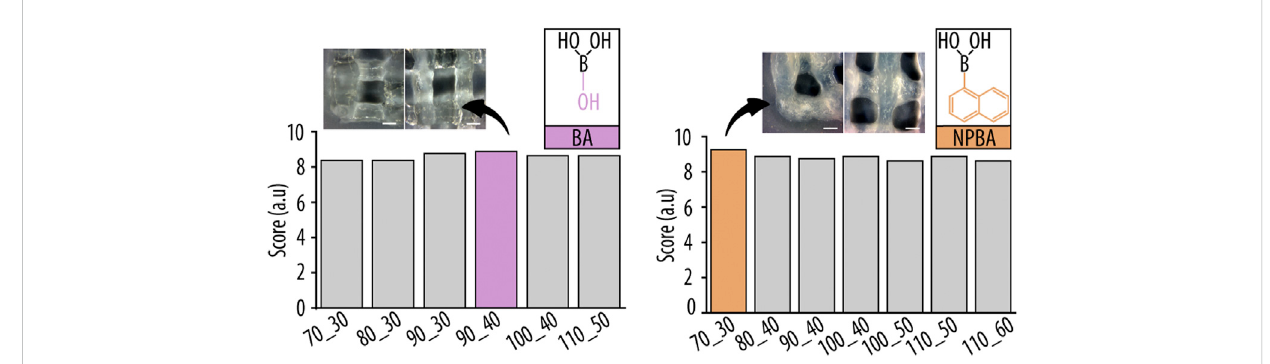
FIGURE 5 Summed and normalized printability scores of the individual hydrogel formulations obtained from fi lament fusion and collapse test. Inserts show representative images of the three dimensional (3D)-printed grid structures, highlighting corners (left) and fi lament cross-sections (right) for the